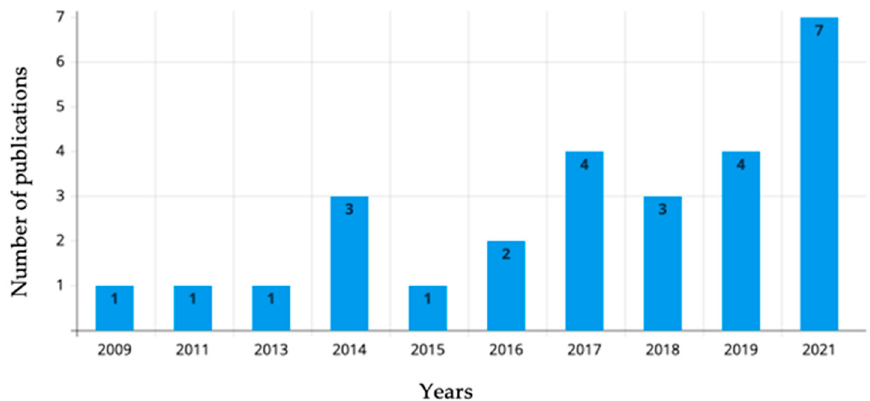
Figure 3. Bar chart showing the number of publications per year.